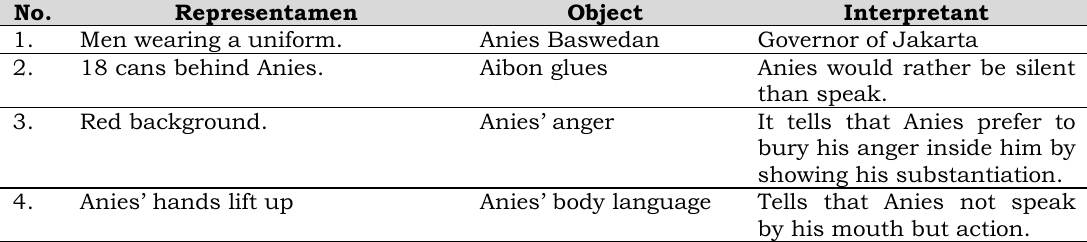
Classification of third political cartoon based on Pierce’s model of